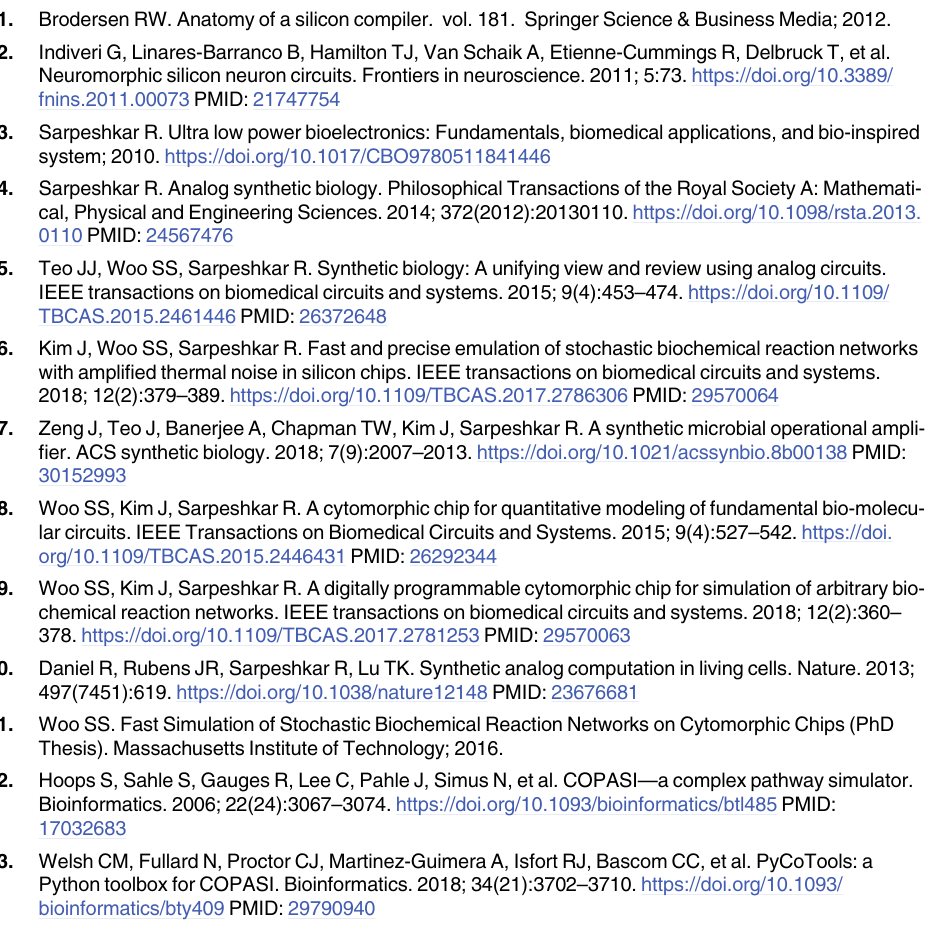
S2 Table. A second replicate of the gain adjustment method for KDfw and KDrv . S8 Fig shows the simulation results for these